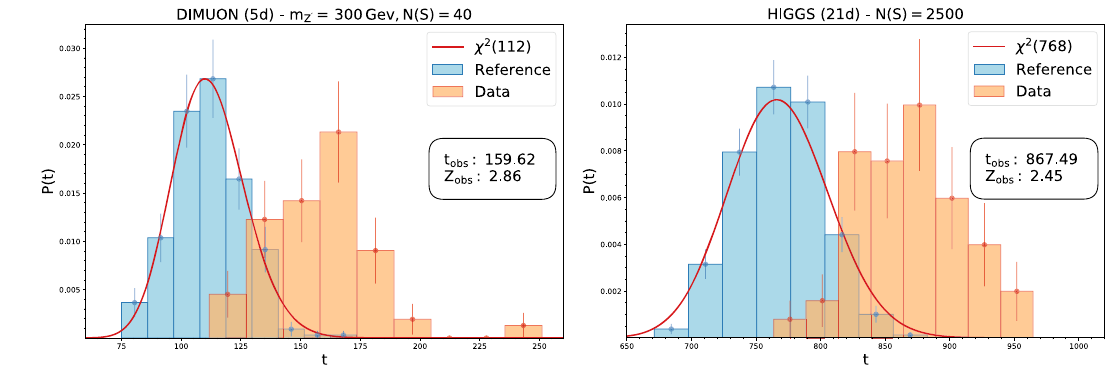
Fig. 1 Distribution of the test statistics under the null and alternative hypotheses for the DIMUON (left) and HIGGS (right)